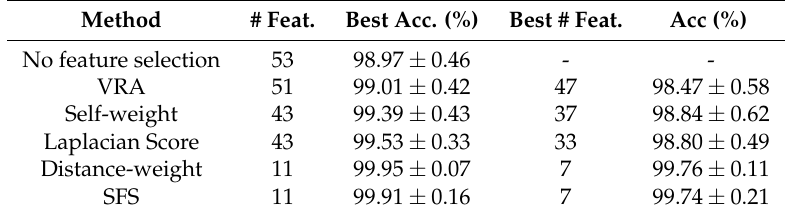
Table 5. Best classification results and number of features required (ten class